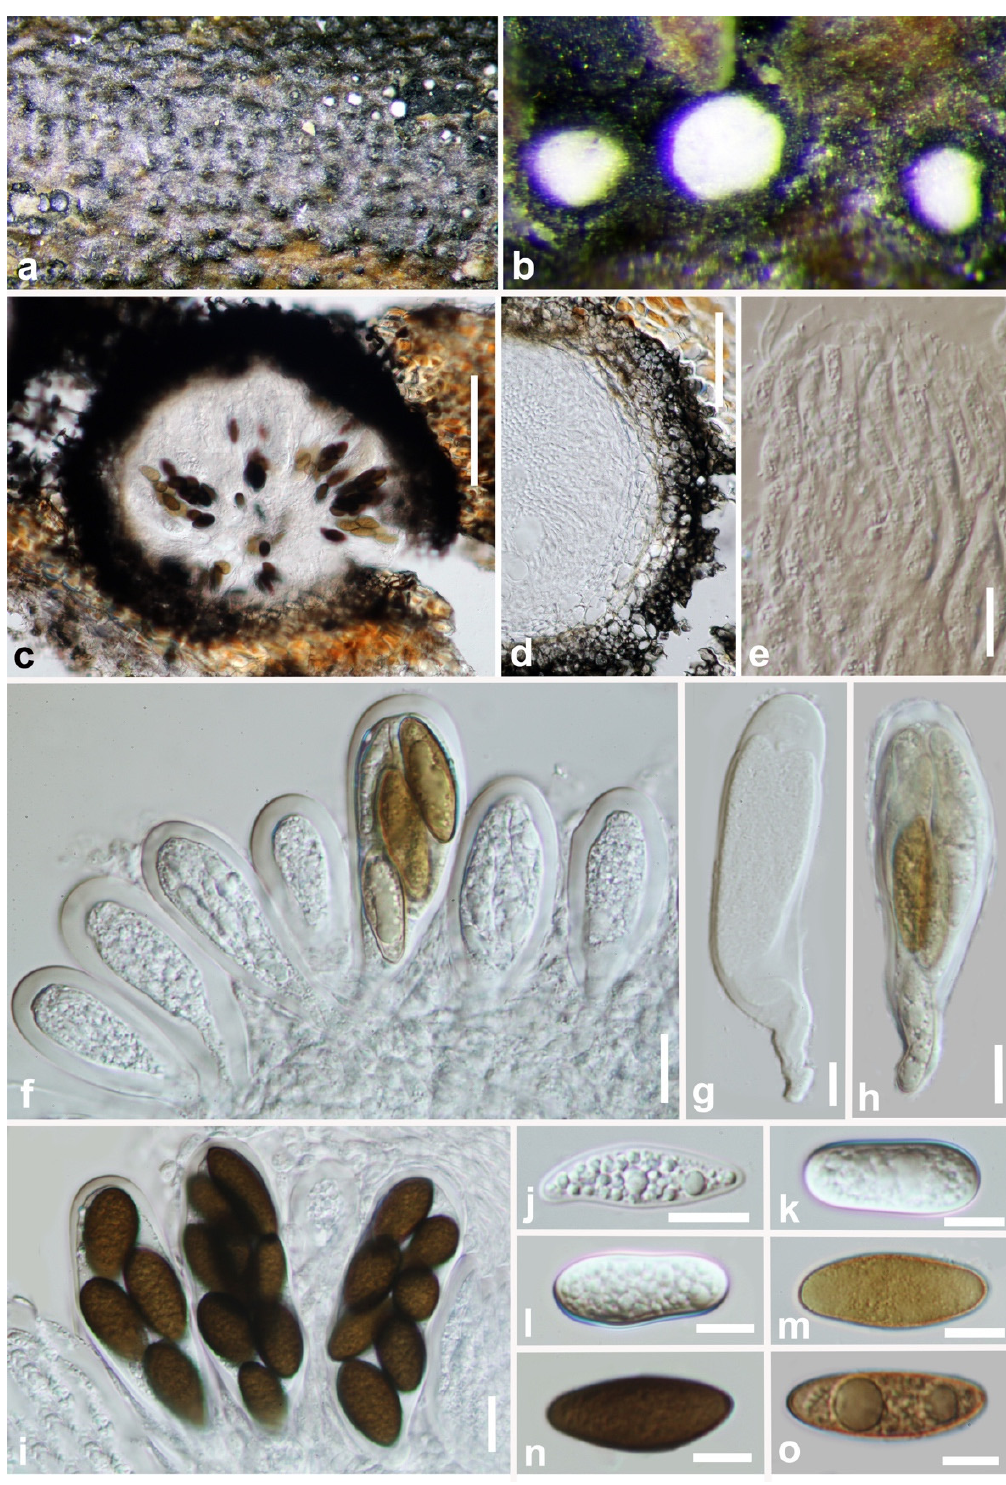
Figure 6. Sardiniella elliptica (HKAS 112594, holotype, sexual morph). ( a , b ) Appearance of ascomata on decaying wood. ( c ) Vertical section of ascomata. ( d ) Peridium. ( e ) Pseudoparaphyses. ( f ) Immature and mature asci. ( g ) Immature ascus. ( h , i ) Mature asci. ( j – l ) Immature hyaline ascospores. ( m – o ) Mature, brown, aseptate ascospores. Scale bars: ( c ) = 100µm, ( d ) = 50 µm, ( e – o ) = 10 µm.